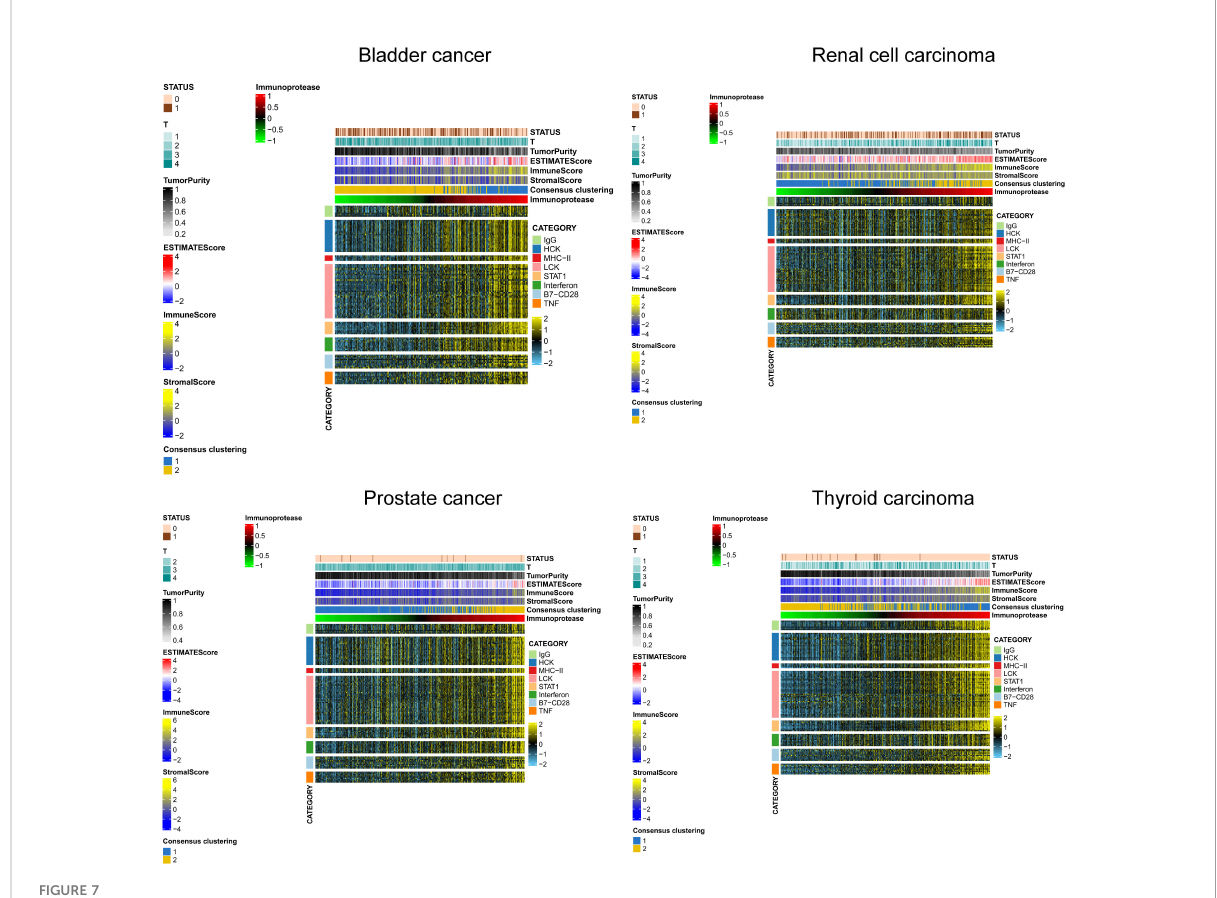
FIGURE 7 IP - Score correlation with immune in fl ammation response.